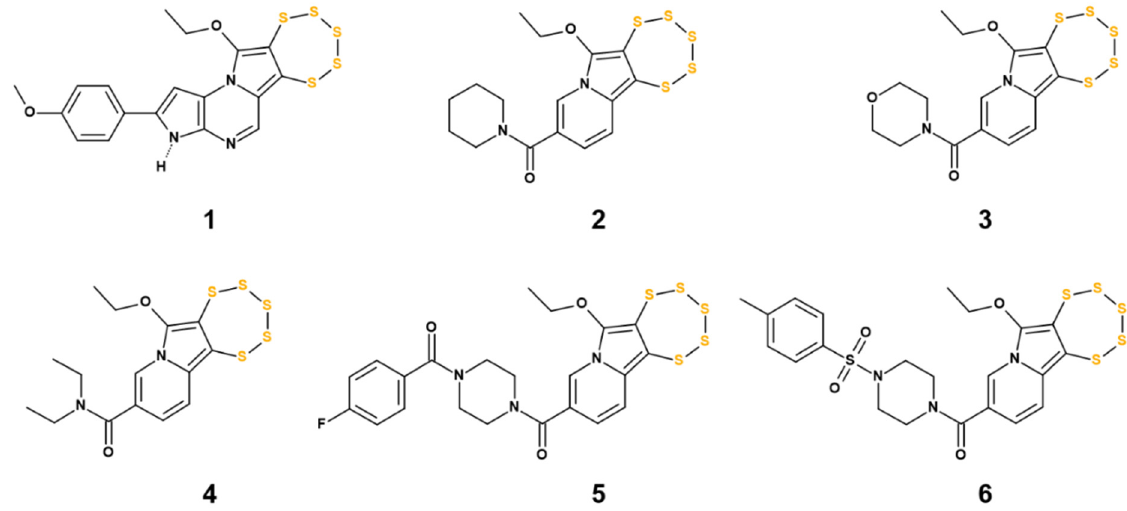
Figure 2. The chemical structures of the novel pentathiepins 1 – 6 that were synthesized and biologically evaluated in this study. Compound 1 contains an aryl-substituted pyrrolo-pyrazine designed to exert fluorescence for intracellular trackability. For the other structures, a nicotinamide backbone was substituted with either a piperidine ( 2 ), morpholine ( 3 ), N , N’ -diethylamine ( 4 ), p-fluorophenone-piperazine ( 5 ), or p -tosyl-piperazine ( 6 ).